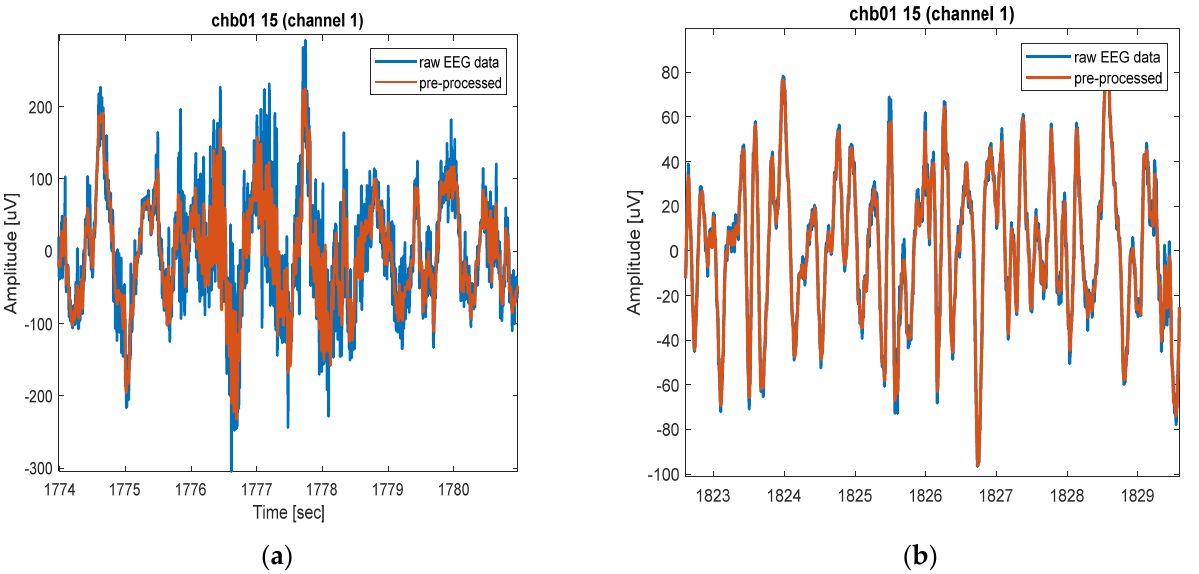
Figure 3. Direct comparison of raw EEG (blue trace) and preprocessed EEG signal. ( a ) Direct comparison of raw EEG (blue trace) and pre-processed EEG signal during artefact. ( b ) Direct comparison of raw EEG (blue trace) and pre-processed EEG signal artefact clean section.